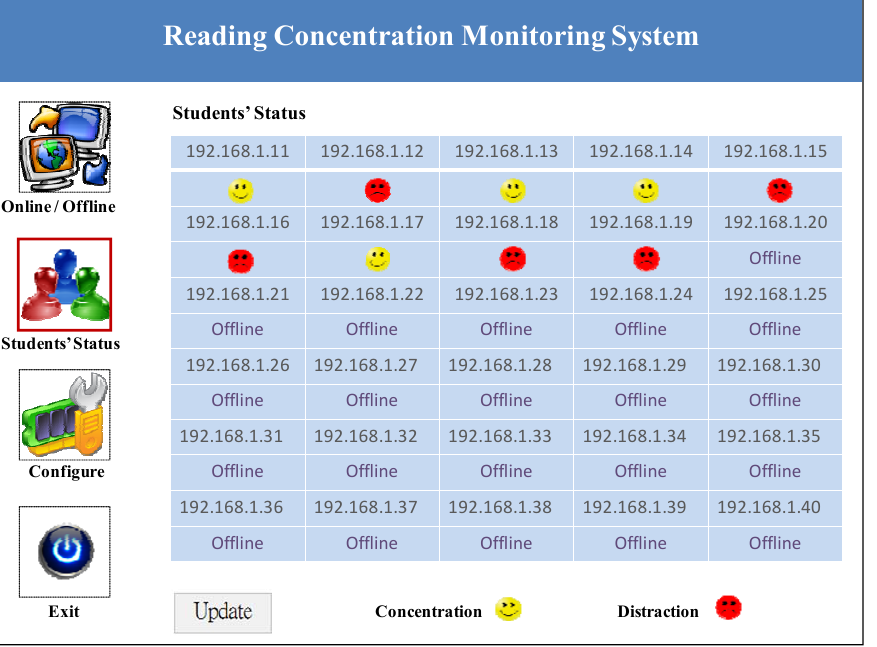
Figure 6. Results of the reading concentration monitoring